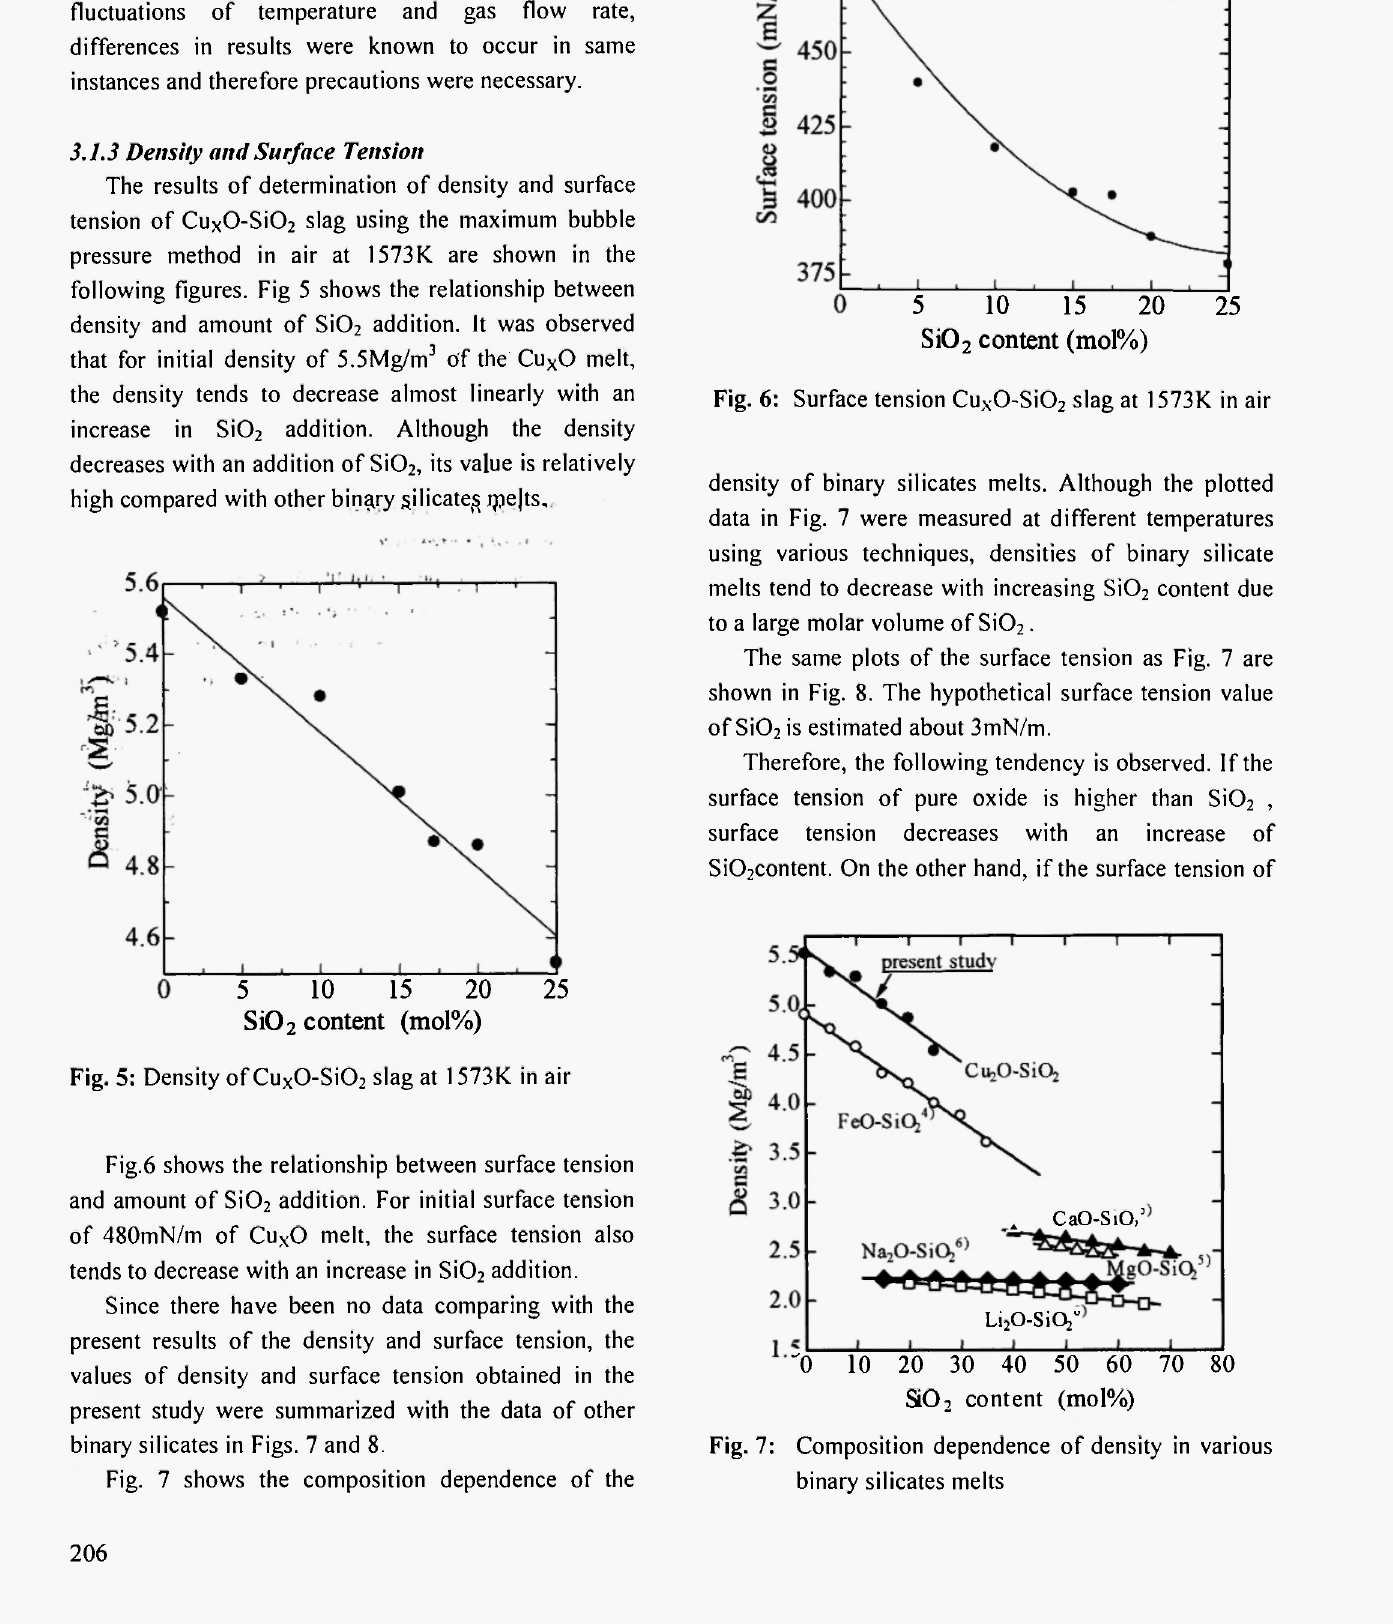
Fig. 6: Surface tension Cu x 0-Si0 2 slag at 1573Κ in air